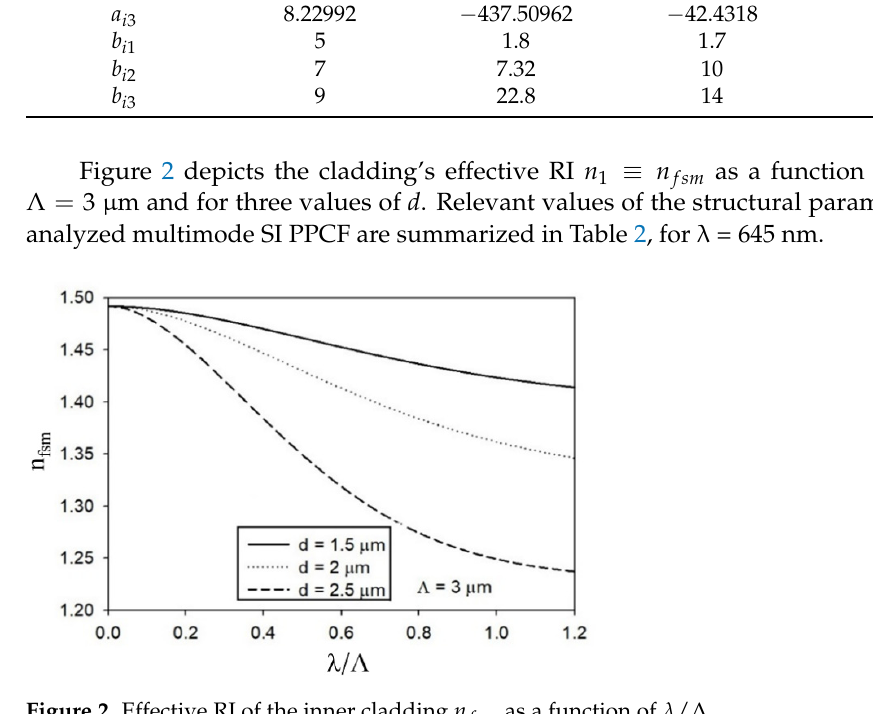
Figure 2. Effective RI of the inner cladding Table 2. Effective RI of the cladding n 1 , relative RI difference ∆ = ( n 0 − n 1 ) / n 0 , where n 1 = 1.492, and the critical angle θ m for varied d (air hole diameter) at 645 nm